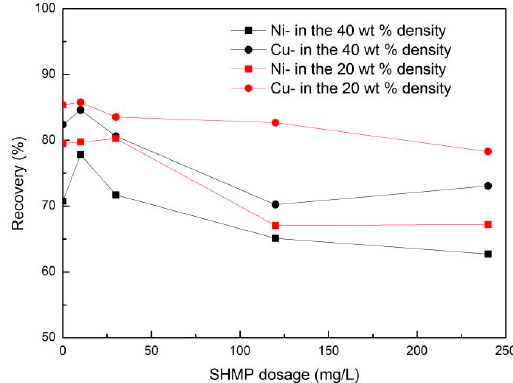
Figure 5 . Effect of SHMP dosage on nickel and copper recovery at 40% and 20% pulp densities of flotation slurries (50 wt % sulfide ore-50 wt % serpentine).